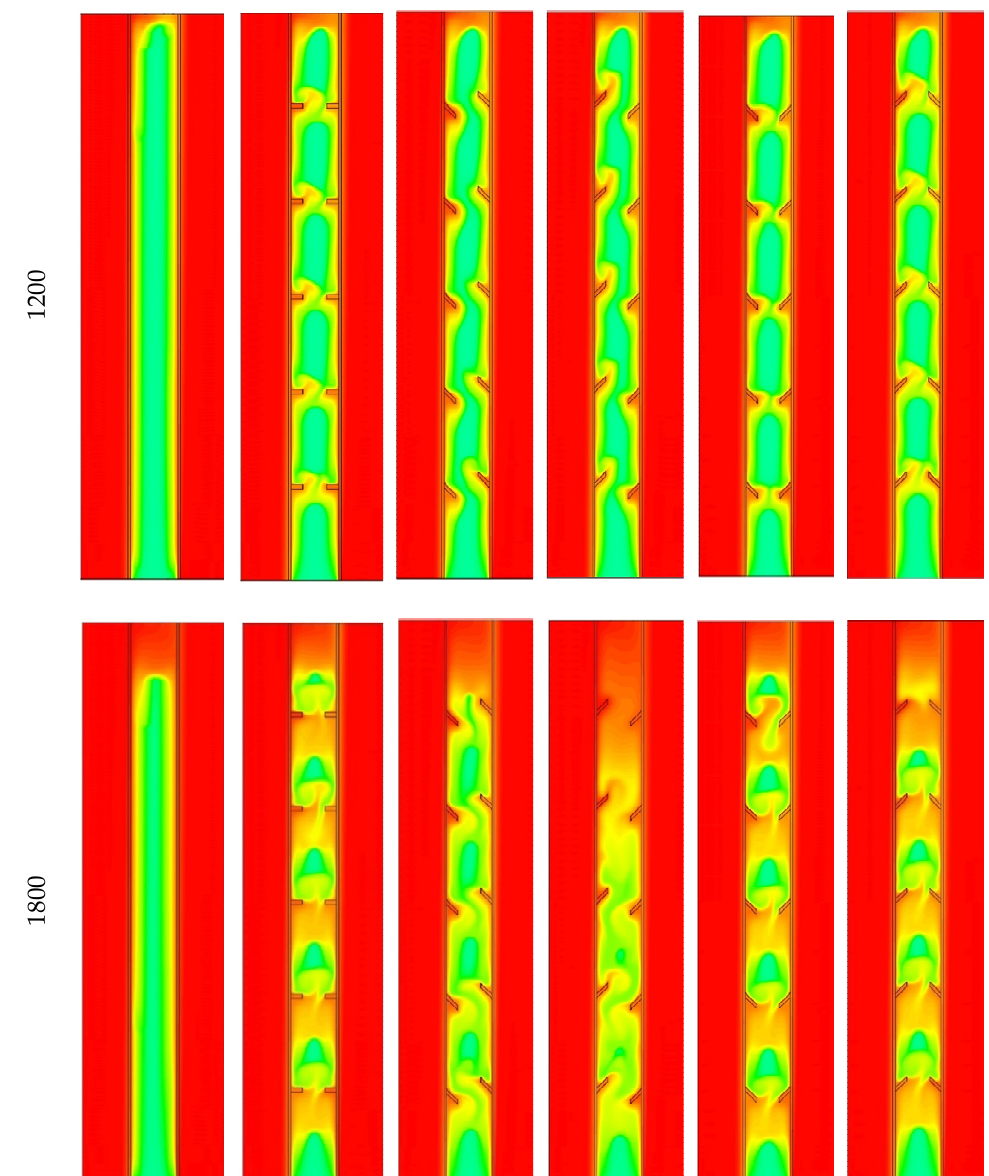
Figure 7. The temperature distribution in 1800 s in three different time steps for the finless case and the cases of different orientations of fins directions.